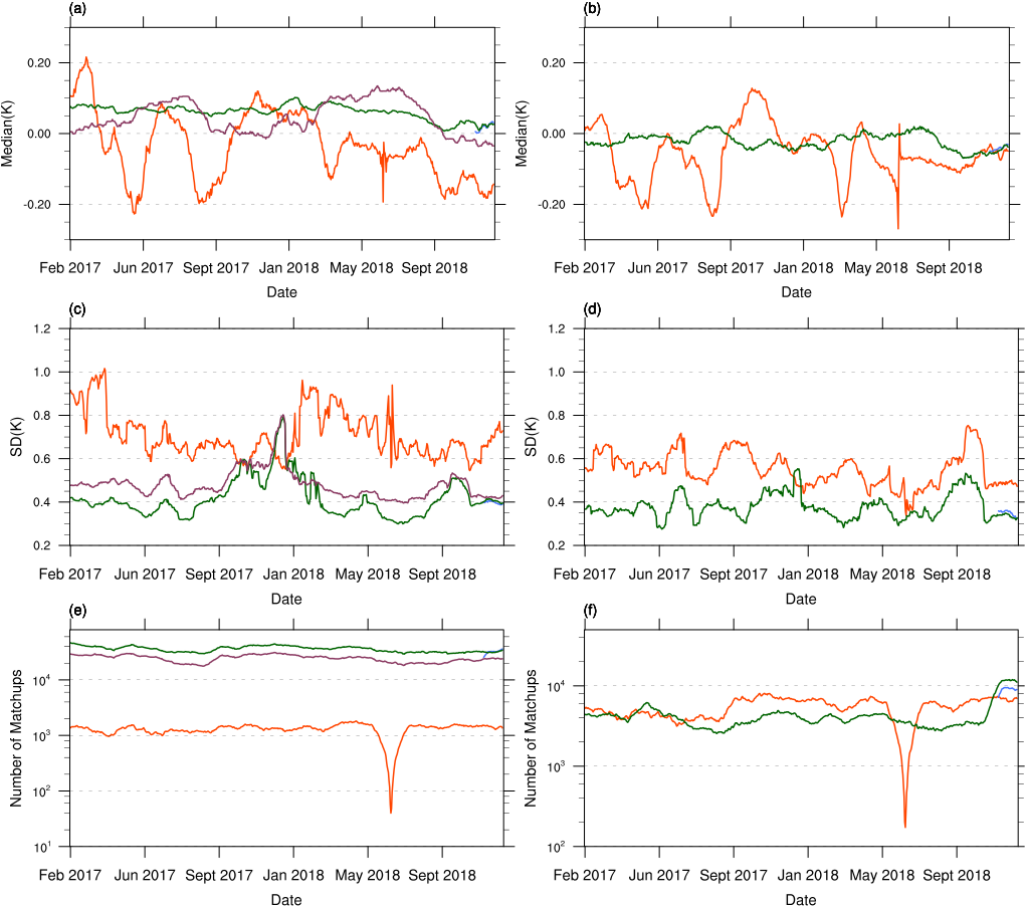
Figure 4. Bias -corrected fv02 L3C-01day, night only, monthly statistics, 1 February 2017–31 December 2018, median for ( a ) QL 4 and ( b ) QL 5, and standard deviation for ( c ) QL 4 and ( d ) QL 5, number of matchups for ( e ) QL 4 and ( f ) QL 5, when compared with drifting and tropical moored buoy’s SST. Note: Matchup thresholds: < 10 km distance and < 6 h time difference. SSTs were obtained from sensors on NOAA–18 (orange), NOAA–20 (blue), NPP (green) and MetOp-B (pink) satellites from